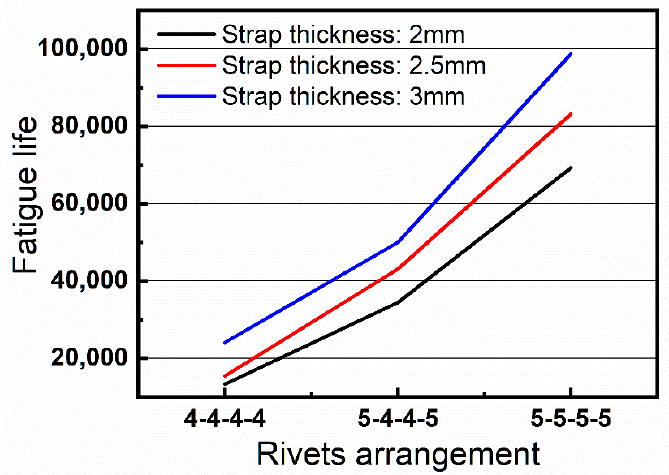
Figure 22. The fatigue lives of different groups of riveted butt joints with various strap thicknesses and rivets sizes.